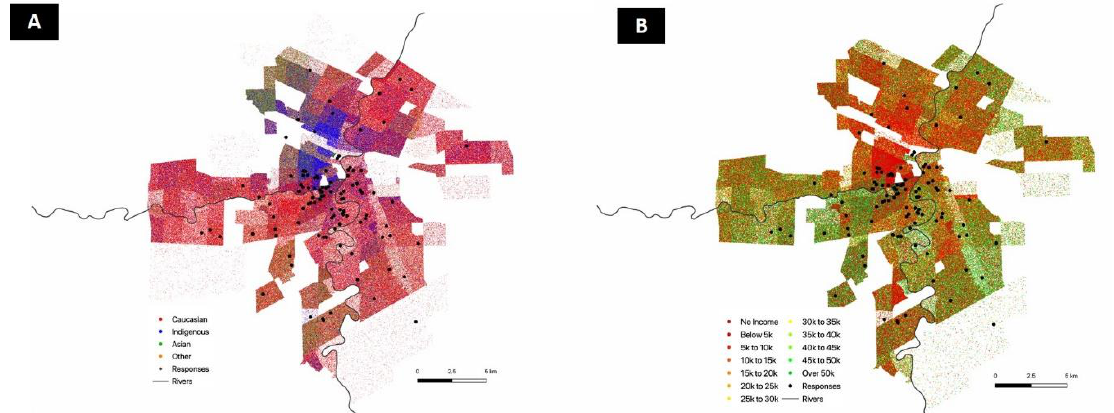
Figure 3. Geomap of trail users. Neighbourhoods from which trail users originated mapped according to A- the geographic ethnic make-up of the city of Winnipeg and B- the geographic household income of the city of Winnipeg.